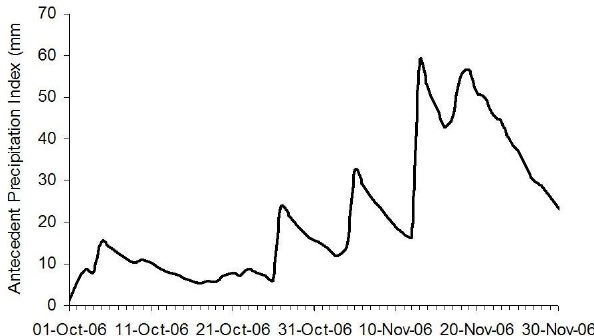
Fig. 3. Antecedent Precipitation Index for the period October– November